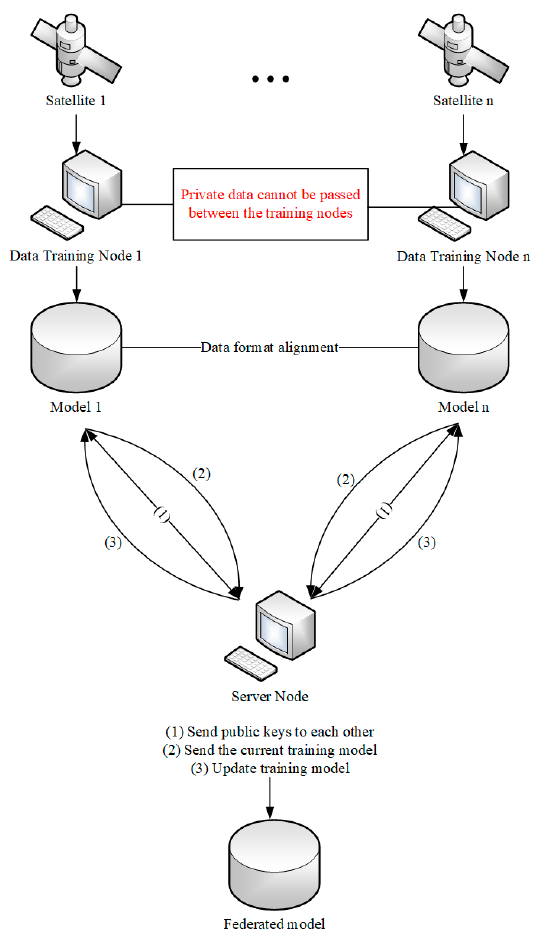
Figure 7. The federated learning Figure 8. The federated learning processing.